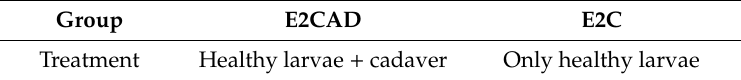
Table 2. Experiment 2: Using sporulating cadavers with Beauveria bassiana . Group E2CAD E2C Treatment Healthy larvae + cadaver Only healthy